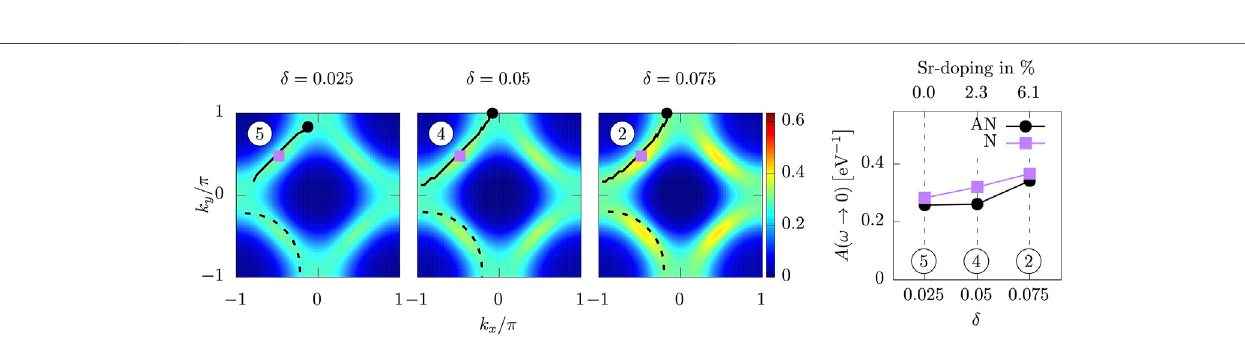
Frontiers in Physics |